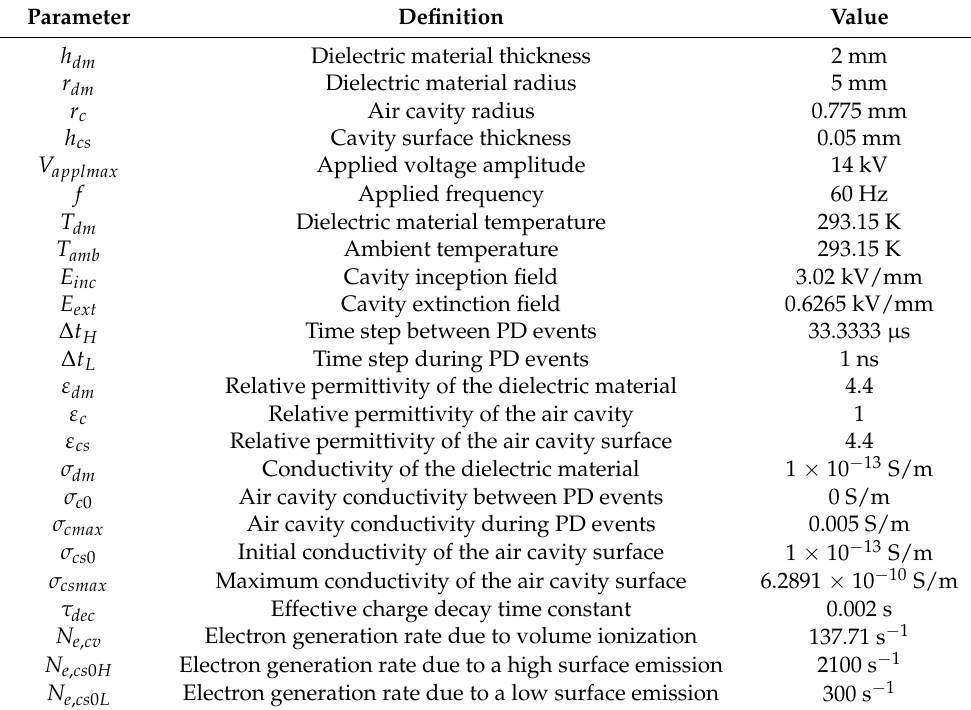
Table 1. PD model